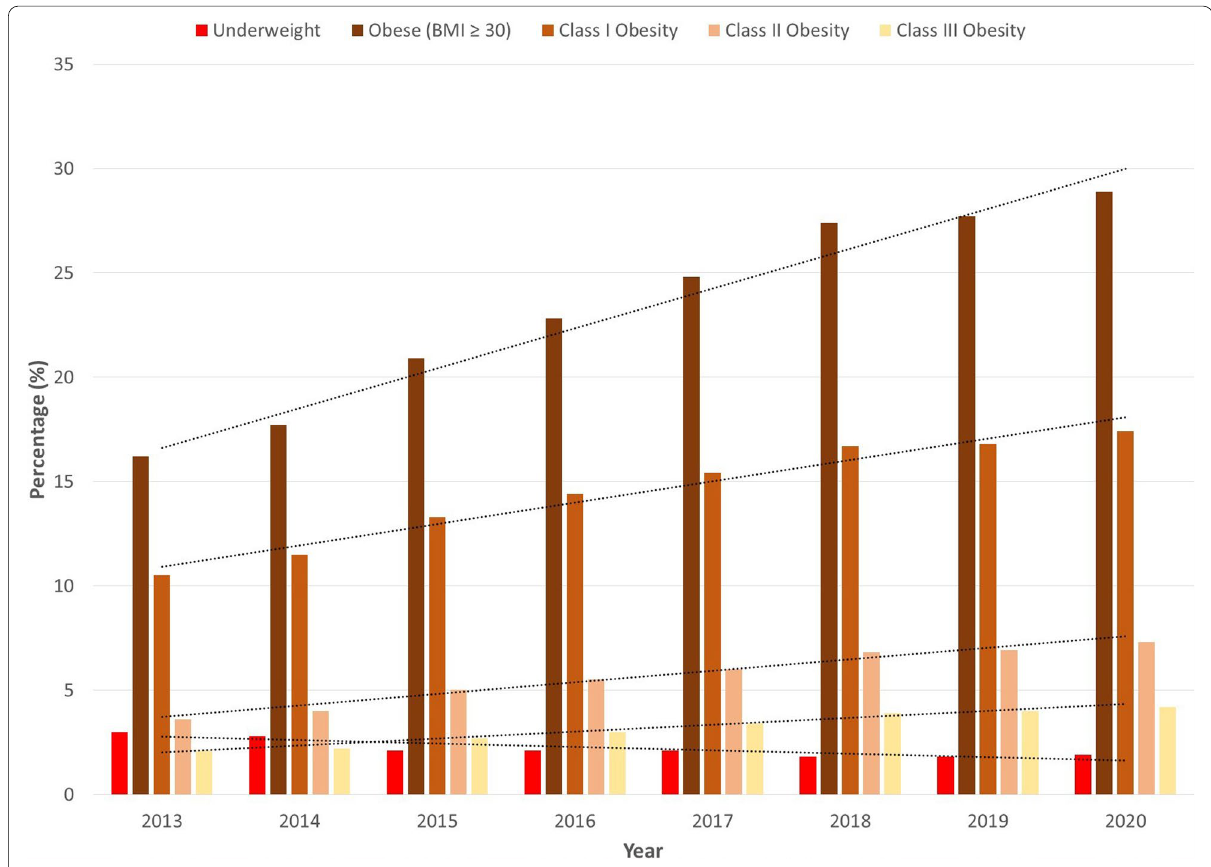
Fig. 2 Proportion of Annual Physical Exam